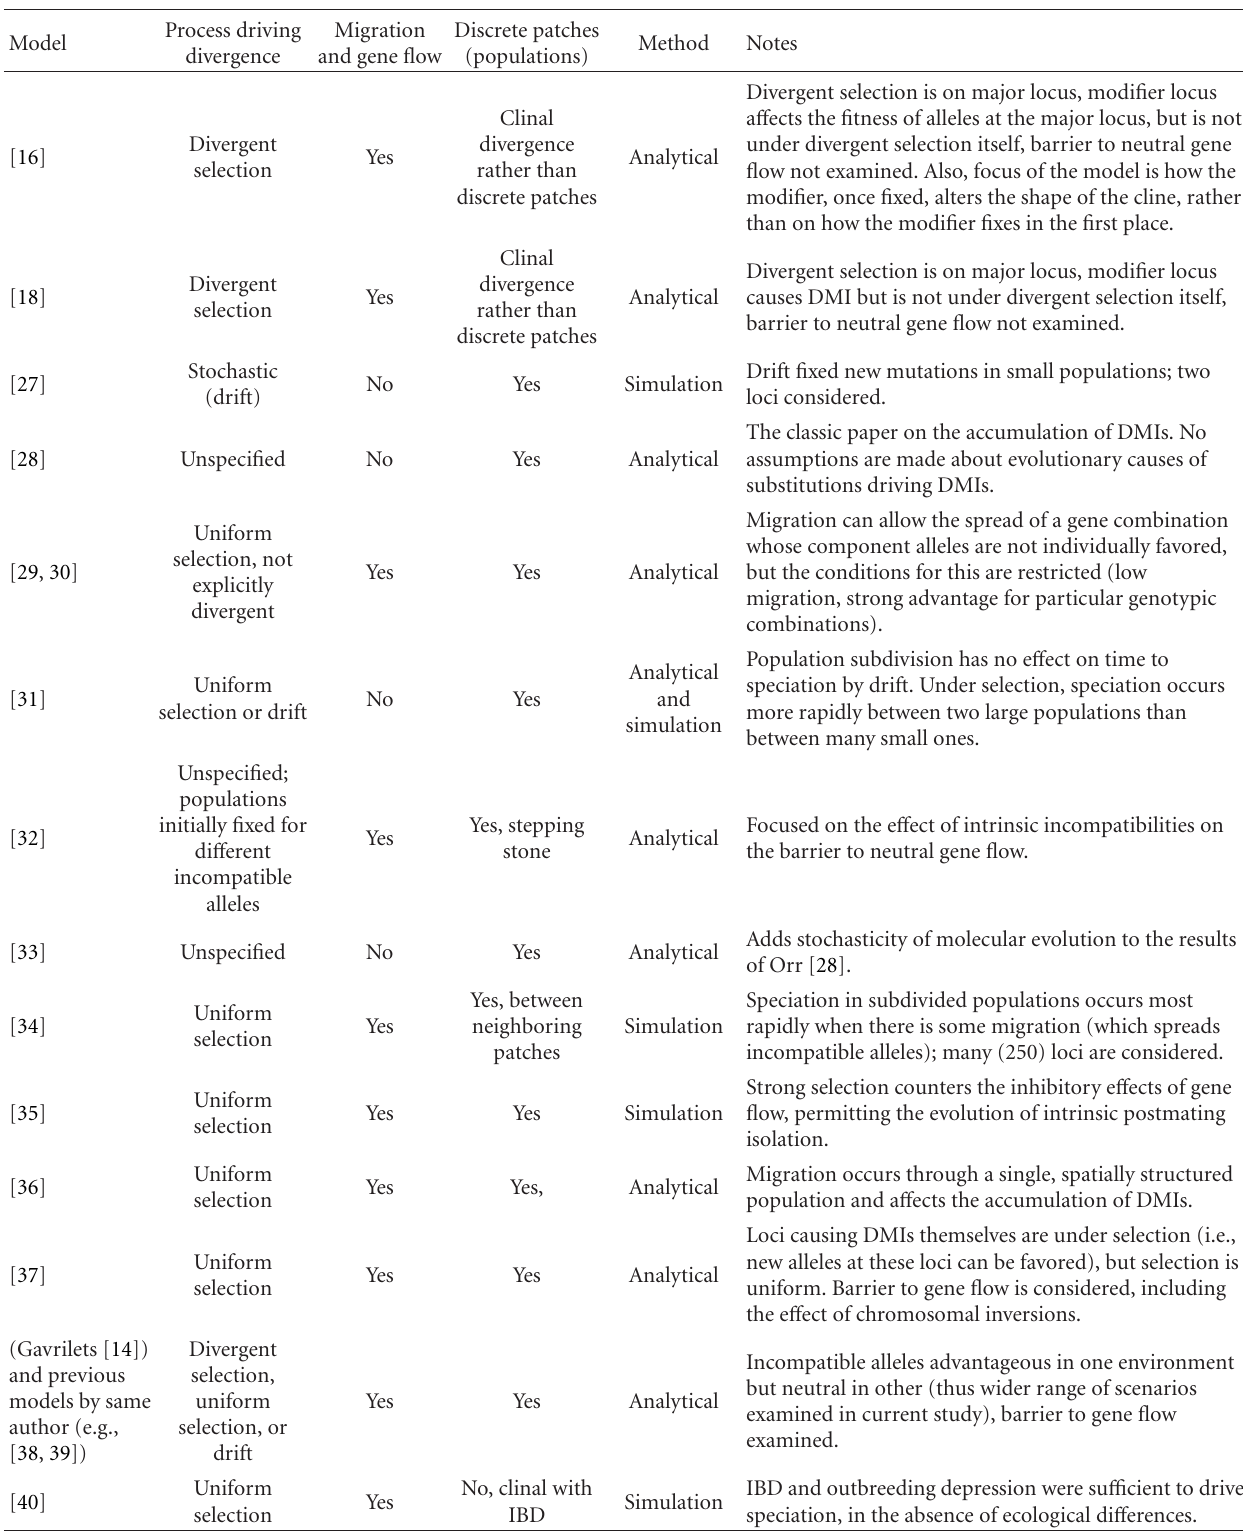
Table 2: In chronological order, a summary of some major previous models of Dobzhansky-Muller Incompatibilities (DMIs). Uniform selection refers to scenarios where selection occurs (i.e., some alleles or genotypic combinations are more fit than others), but selection is not divergent between di ff erent ecological environments (i.e., no environmental variation). Uniform selection thus fits the “mutation-order speciation” model recently advanced by Schluter [26]. In contrast, divergent selection fits the ecological speciation model. IBD: Isolation-